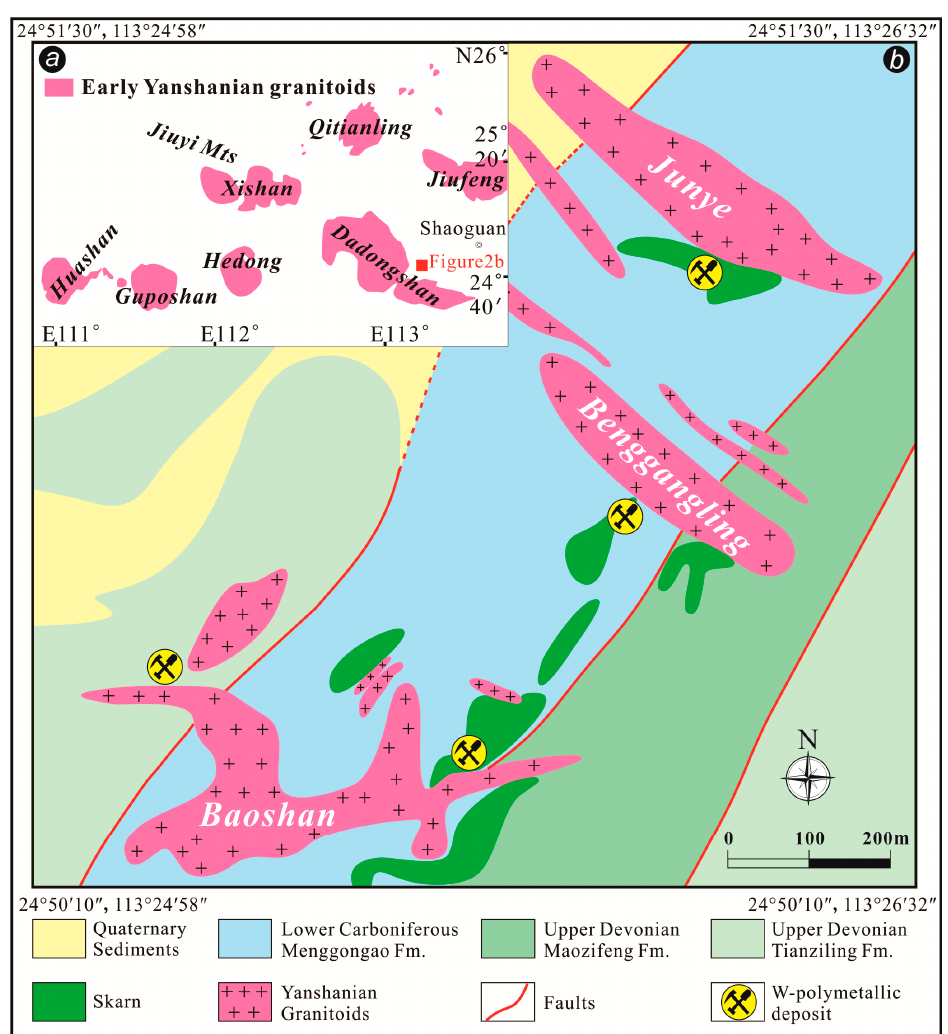
Figure 2. Simplified geological map of the western-middle part of the Nanling mountains region ( a ), modified after Zhu et al. [50], and the Yiliu region ( b ), exhibiting the distribution of early Yanshanian granites.